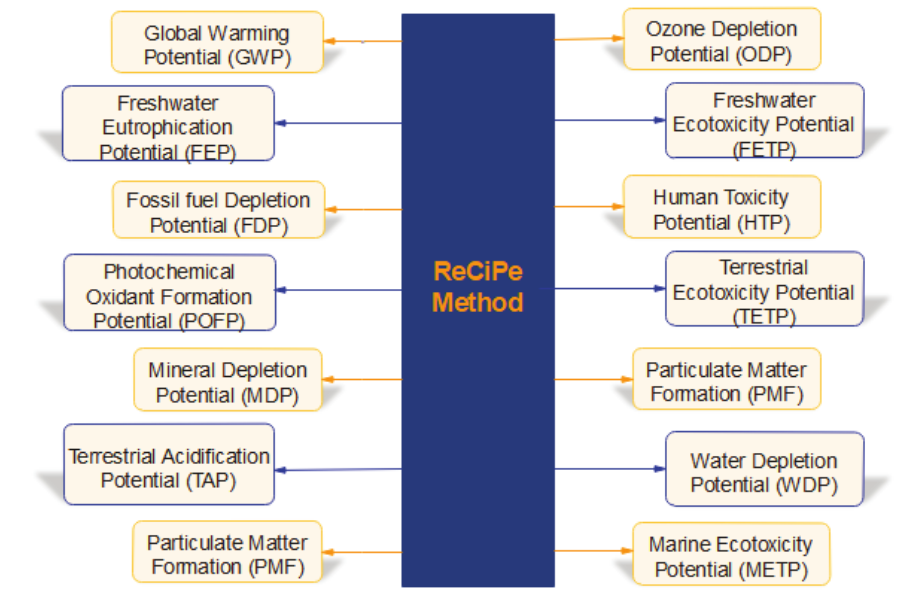
Fig. 8 – Impact categories according to ReCiPe method